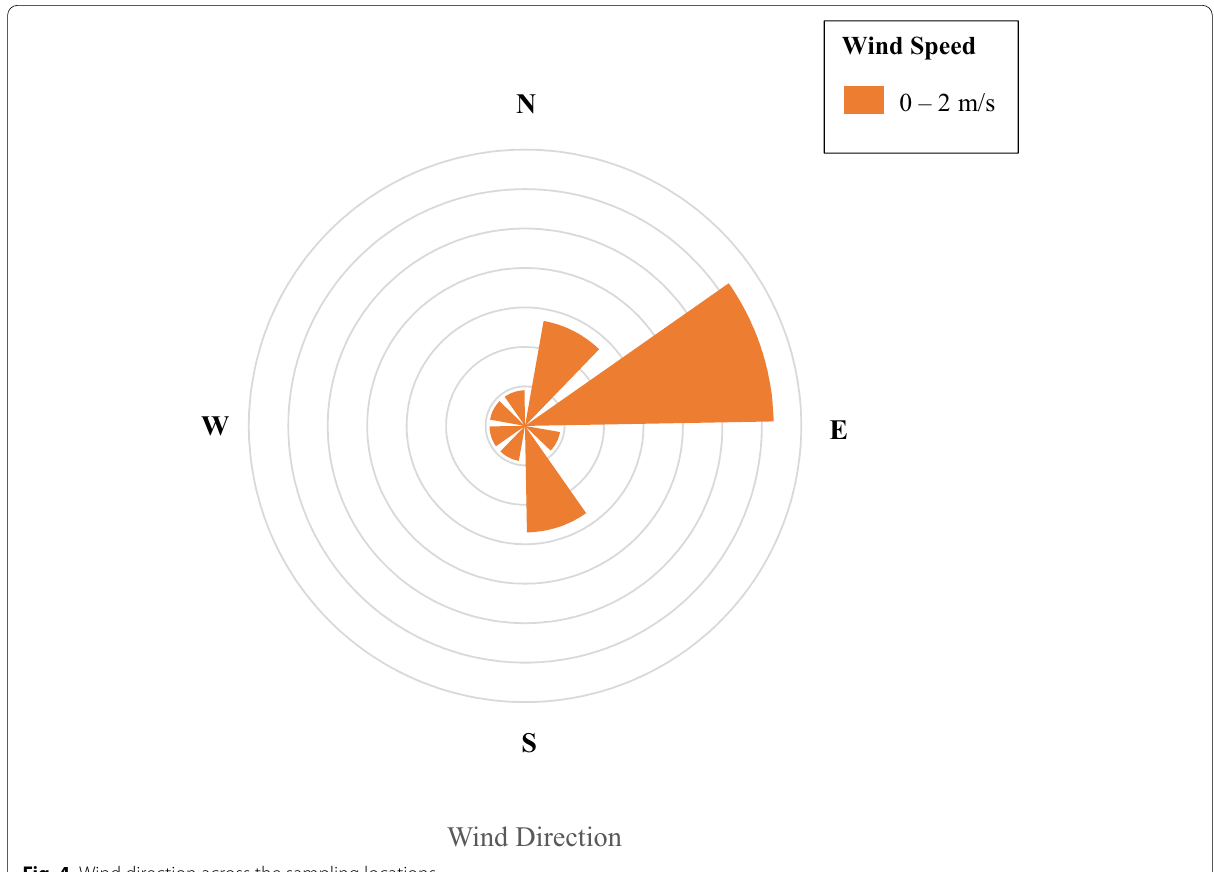
Fig. 4 Wind direction across the sampling locations